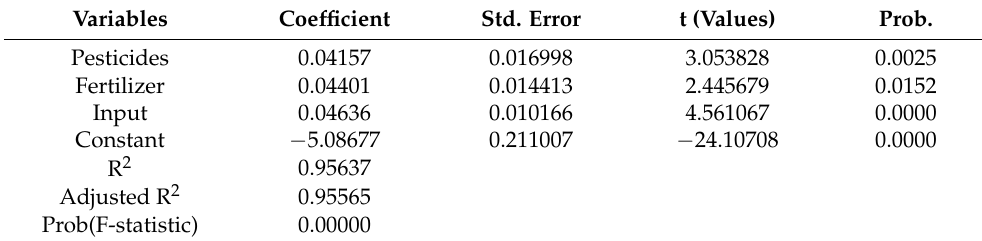
Table 3. Uneducated farmers.